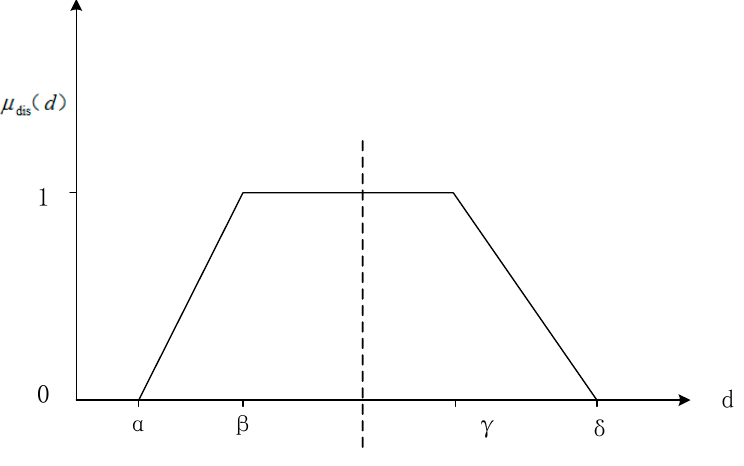
Figure 6. Illustration of the fuzzy distance membership function. In Equation (1), β and γ are the deviation from the correct distance, and α and δ may be derived from the fuzzy distance distribution.